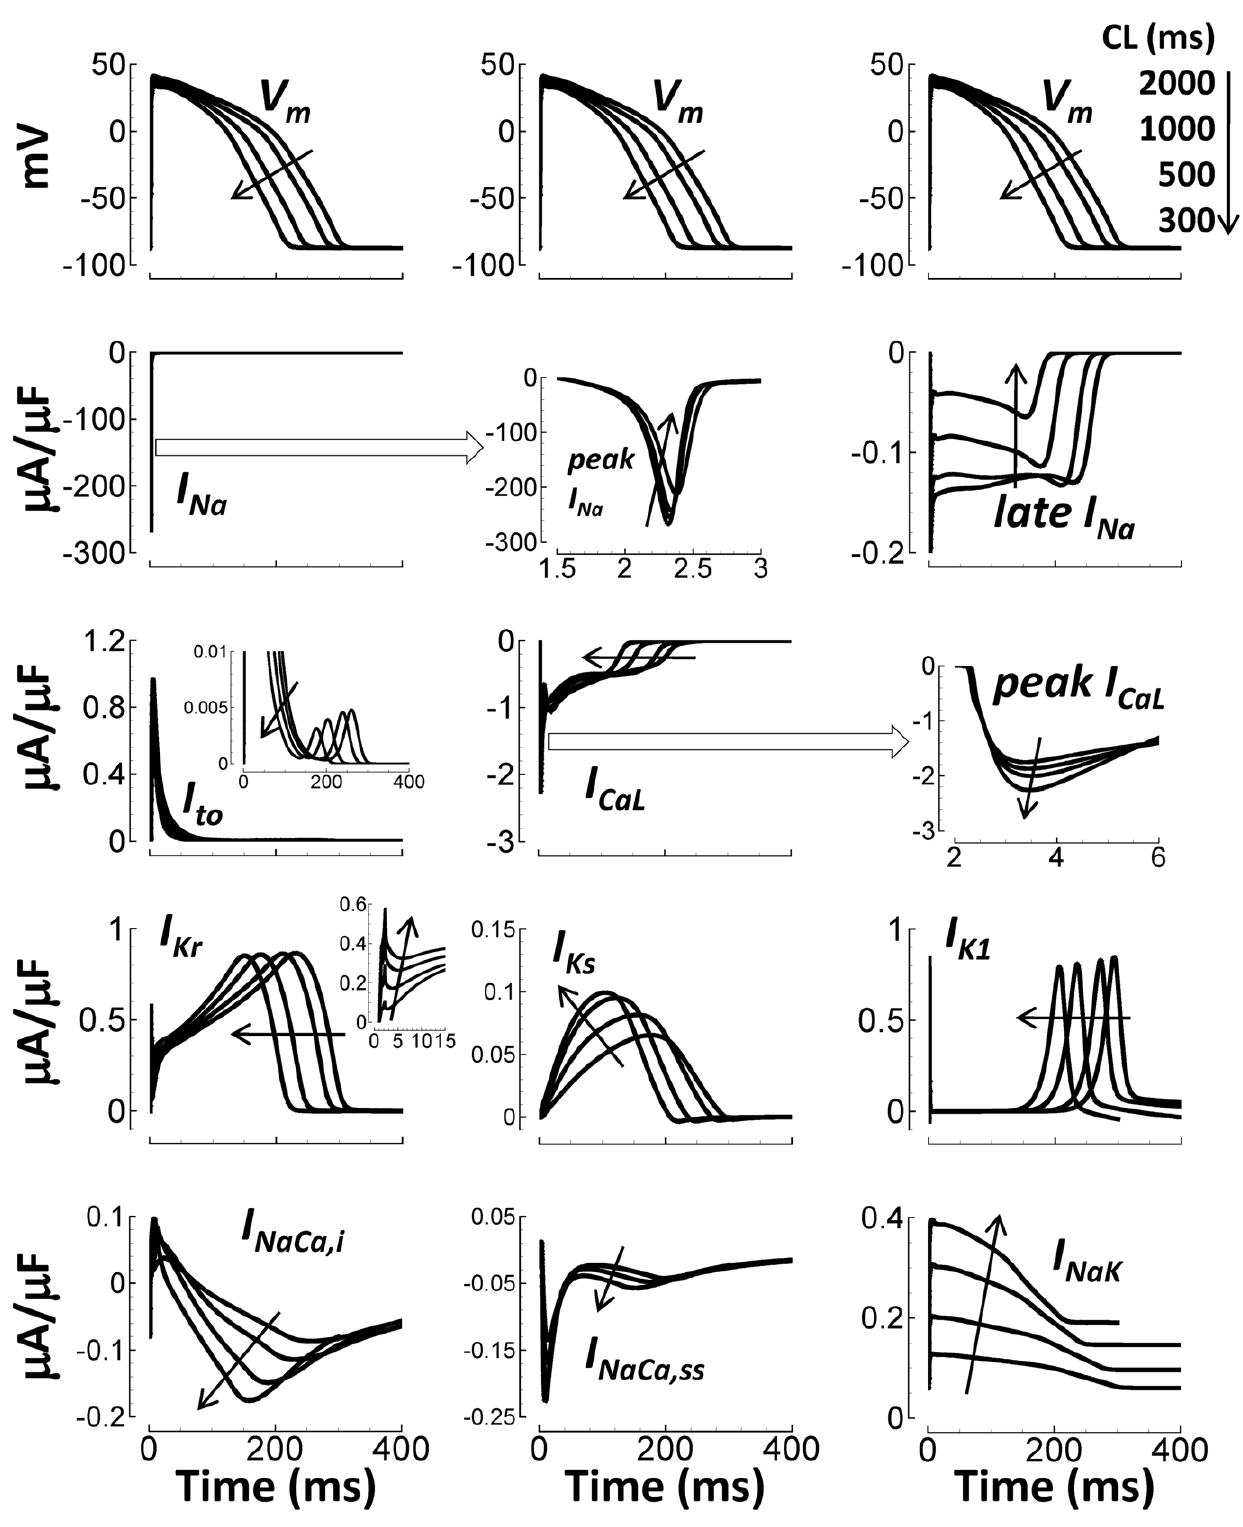
Figure 9. Rate dependence of currents at steady state. Black arrows indicate CL decrease (rate increase). Top Row) Simulated APs, repeated in each column for timing purposes. Lower Rows (left to right, top to bottom): I Na , peak I Na detailed time course, late I Na , I to , I CaL , I CaL increasing peaks with increasing pacing rate, I Kr , I Ks , I K1 , I NaCa,i , I NaCa,ss , and I NaK . Insets show greater detail of late small I to window current, and early I Kr spiking at fast rates.